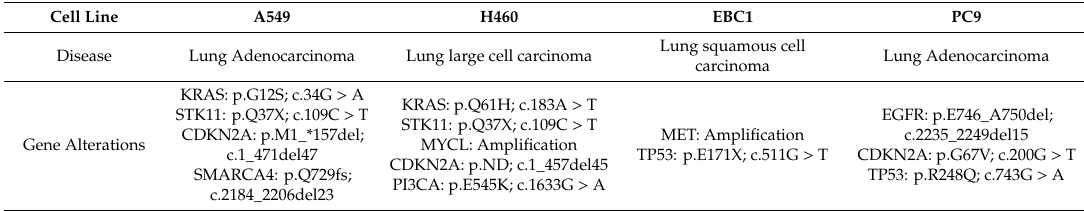
Table 1. Characteristics of cell lines